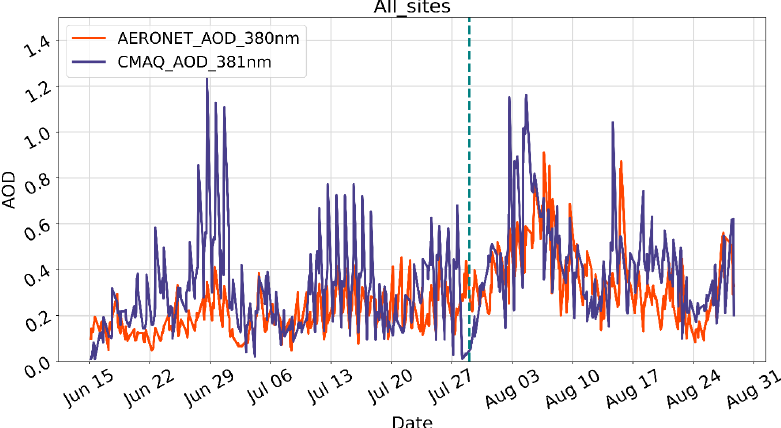
Figure D1. Hourly AOD averaged over all six AERONET sites, both from the CMAQ simulations and AERONET observations. A vertical dotted line on 29 July indicates the start of the second simulation.